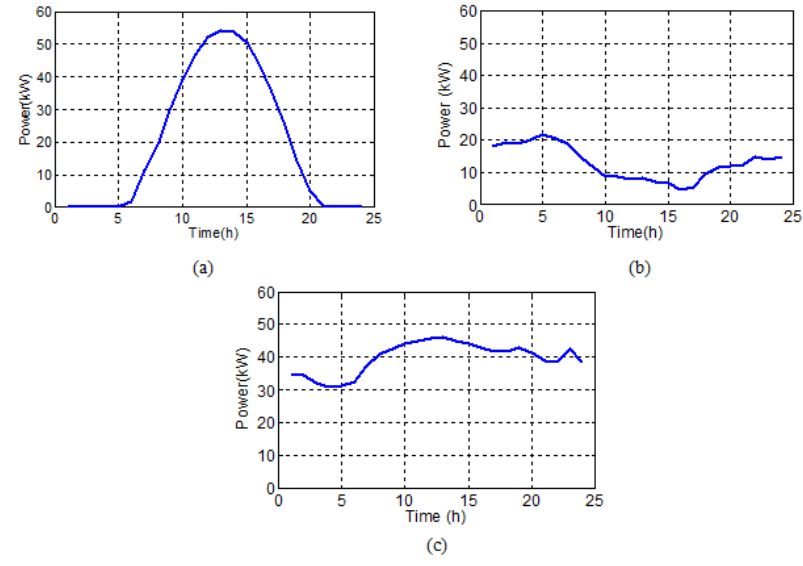
Figure 5. The data per hour of loads, PV system and wind production ( a ) the PV system; ( b ) the wind energy system; ( c ) the loads. The simulation parameter values are shown in Table